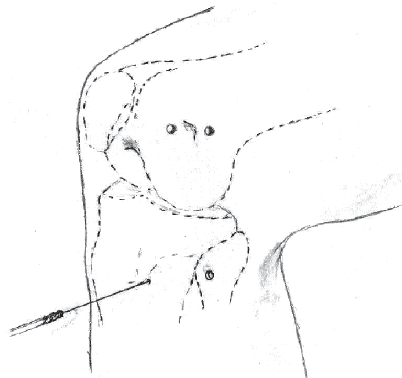
Figure 4 - Division of an iliotibial tract graft. These two portions will be responsible for the reconstruction of the popliteal tendon and popliteal fibular ligament.